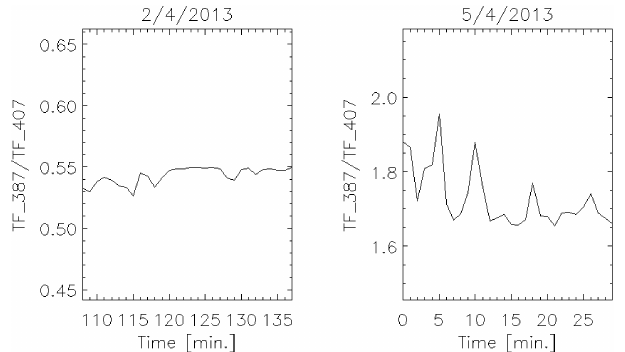
Figure 5. Left: representation scheme of the R tf values in func- tions of the illuminated portions of the RMR-H 2 O telescope sur- face. Right: example of the partial illumination of the mirror by the optical arrangement of the calibration lamp.